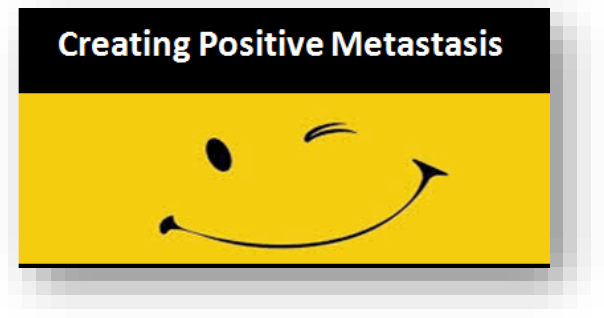
Figure 5. Creating Positive Metastasis Logo.